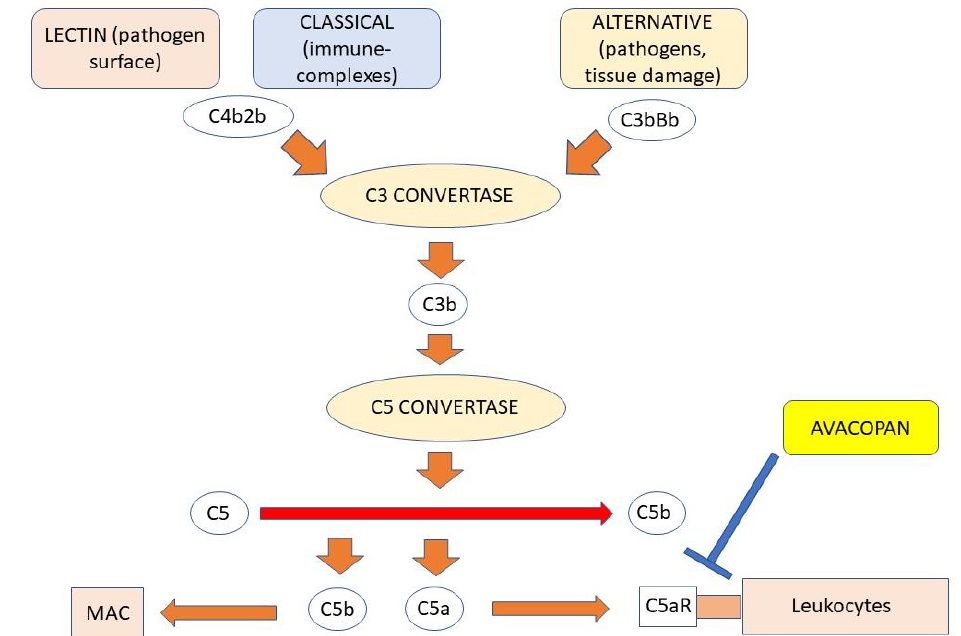
Figure 2. The role of complement. Activation of the alternative complement pathway results by a cascade mechanism in the synthesis of factor C5a, which after recognition of its C5aR receptor on the surface of leukocytes activates them to produce factors that mediate tissue damage. Avacopan, a C5aR agonist, inhibits C5a binding thereby blocking activation of leukocytes including neutrophils.